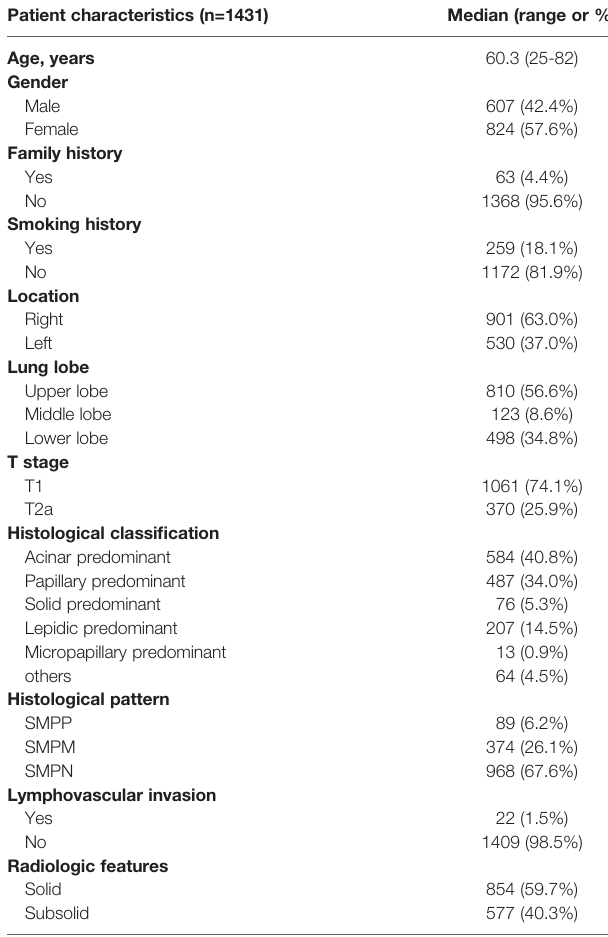
TABLE 1 | Clinicopathological characteristics of the